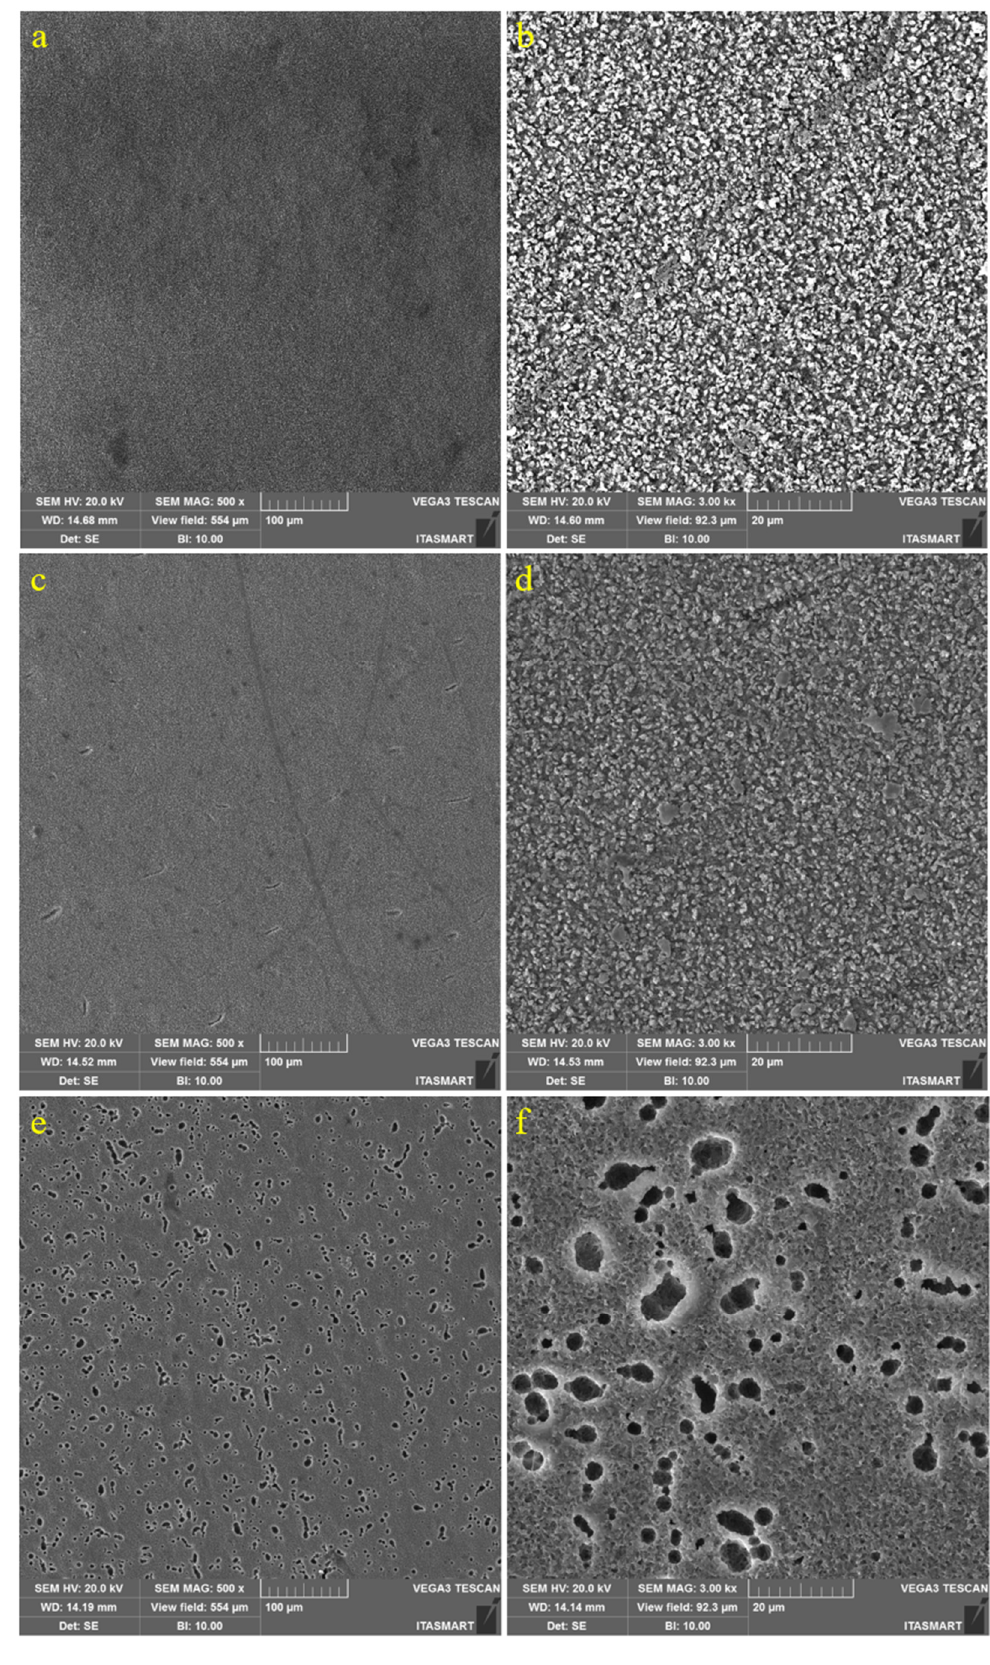
Figure 6. SEM images after the surfaces etching (HF 5%): ( a , b ) ZLS without crystallization firing, ( c , d ) ZLS with crystallization firing, and ( e , f ) LD with crystallization firing.